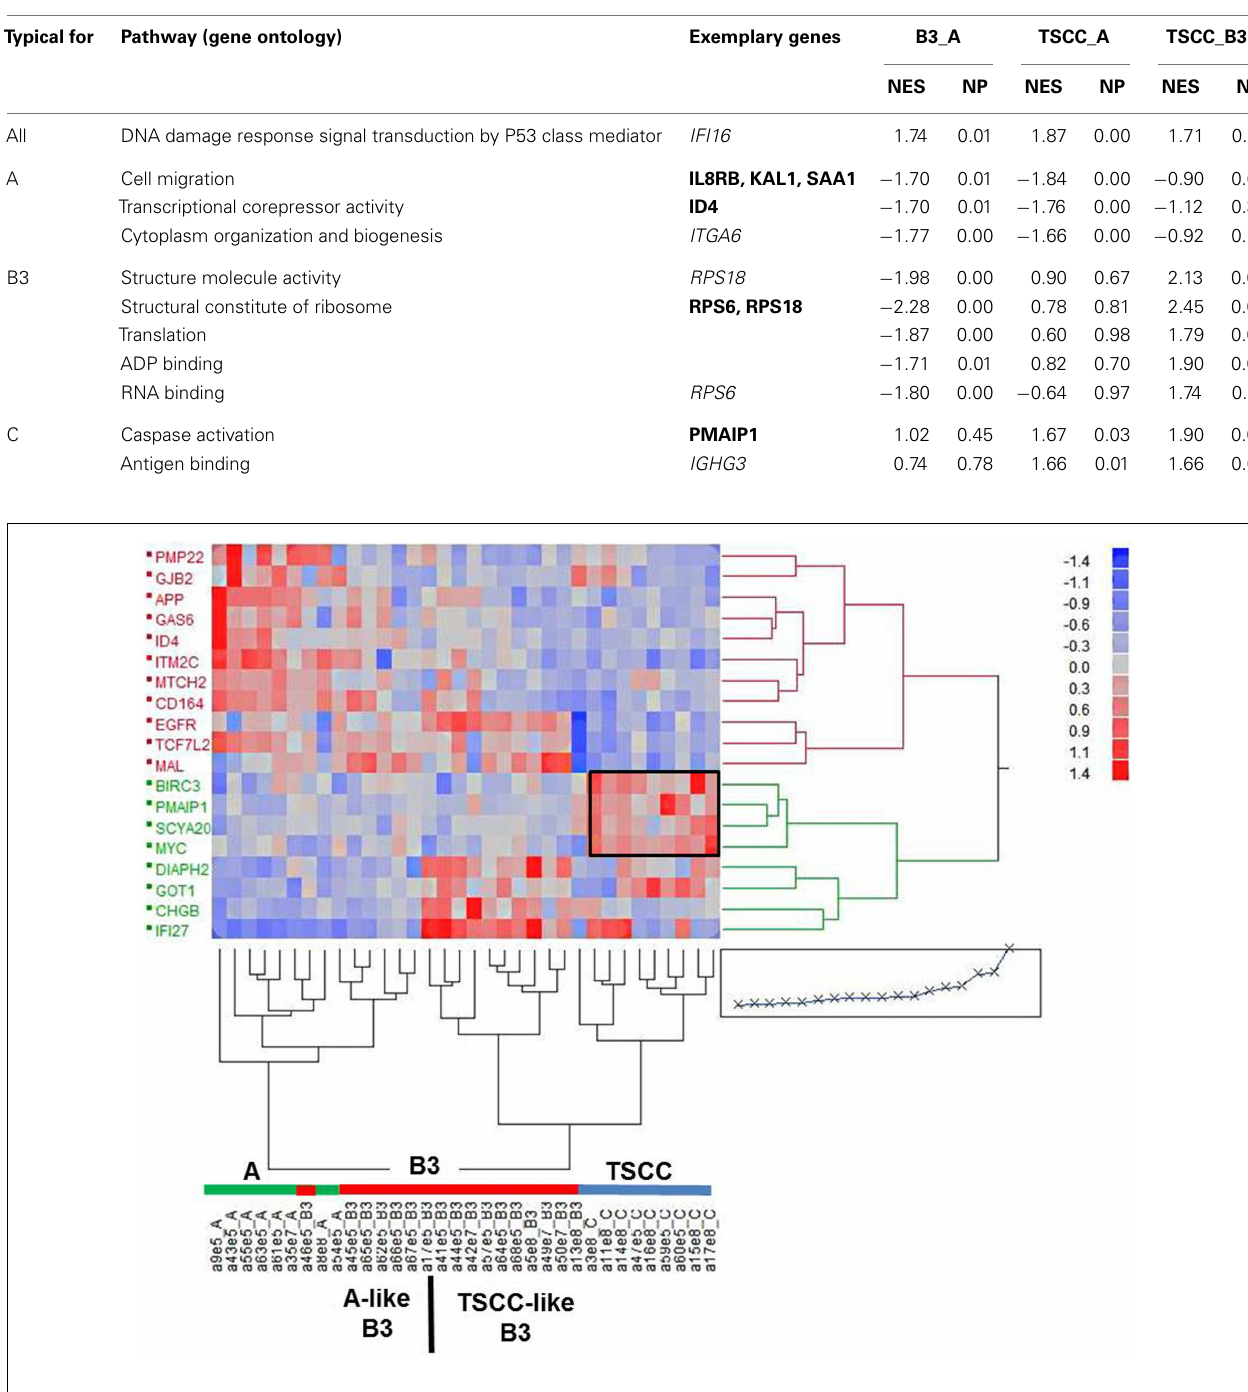
type A thymomas and six of the (“type A-like”) B3 thymomas.The other cluster harbors all theTSCC and 11 of the (TSCC-like) B3 thymomas.The frame highlights a cluster of apoptosis-related genes (BIRC3, SCYA20, PMAIP1, MYC,